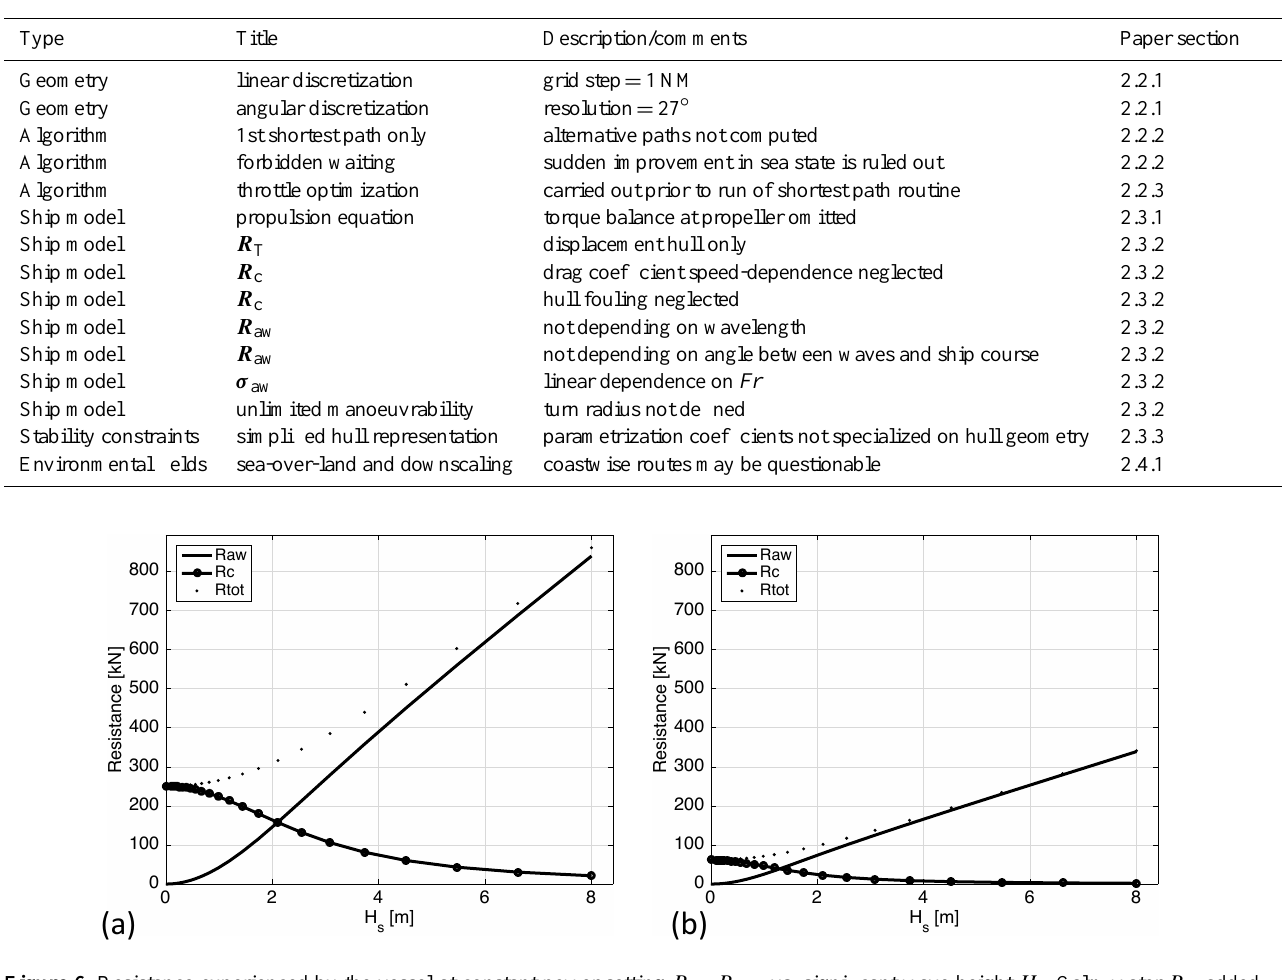
Figure 6. Resistance experienced by the vessel at constant power setting P wave resistance R aw and their sum R T are displayed. Panel (a) and (b) refers to ship parameters for vessel V1 and V2 in Table 5,